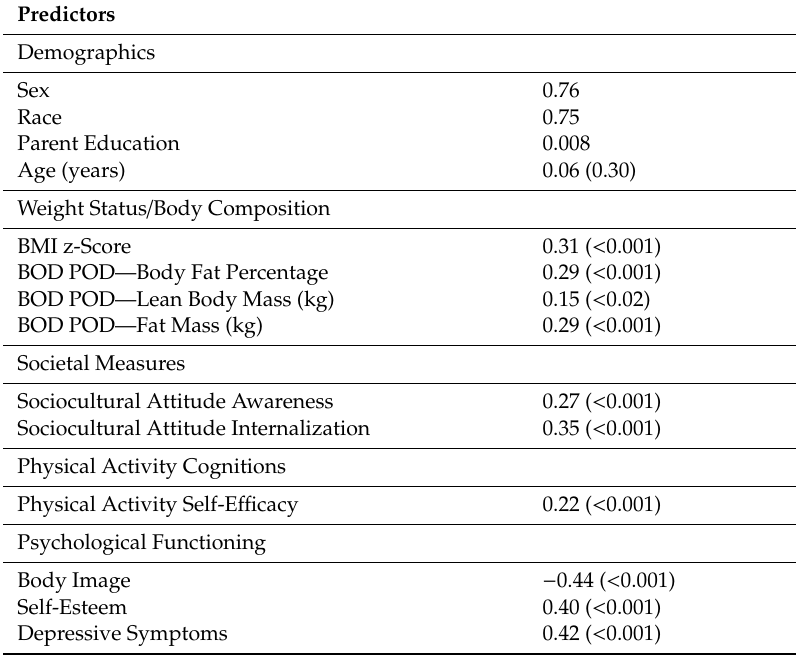
Table 2. Bivariate Analyses of Predictors with Frequency of Weight-Related Teasing.